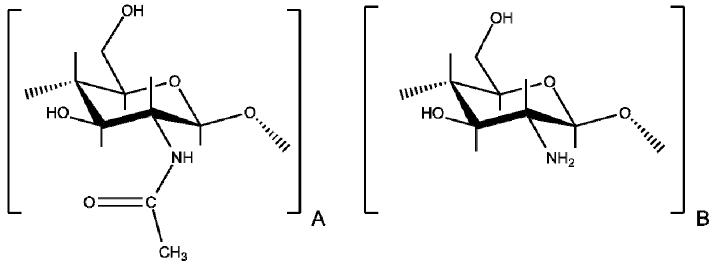
Figure 1. Chemical structure of chitosan composed of β (1 → 4) linked units of ( A ) N -acetyl- D - Chemical structure of chitosan composed of β (1 → 4) linked units of ( A ) glucosamine and ( B ) D -glucosamine. N -acetyl- D -glucosamine and ( B ) D